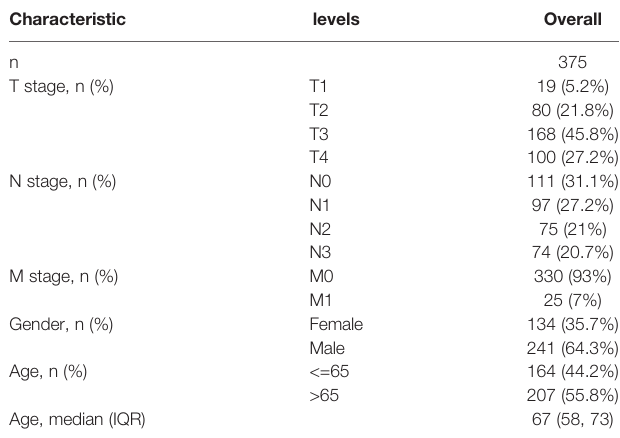
TABLE 1 | Clinical characteristics of the GC patients used in the derivation